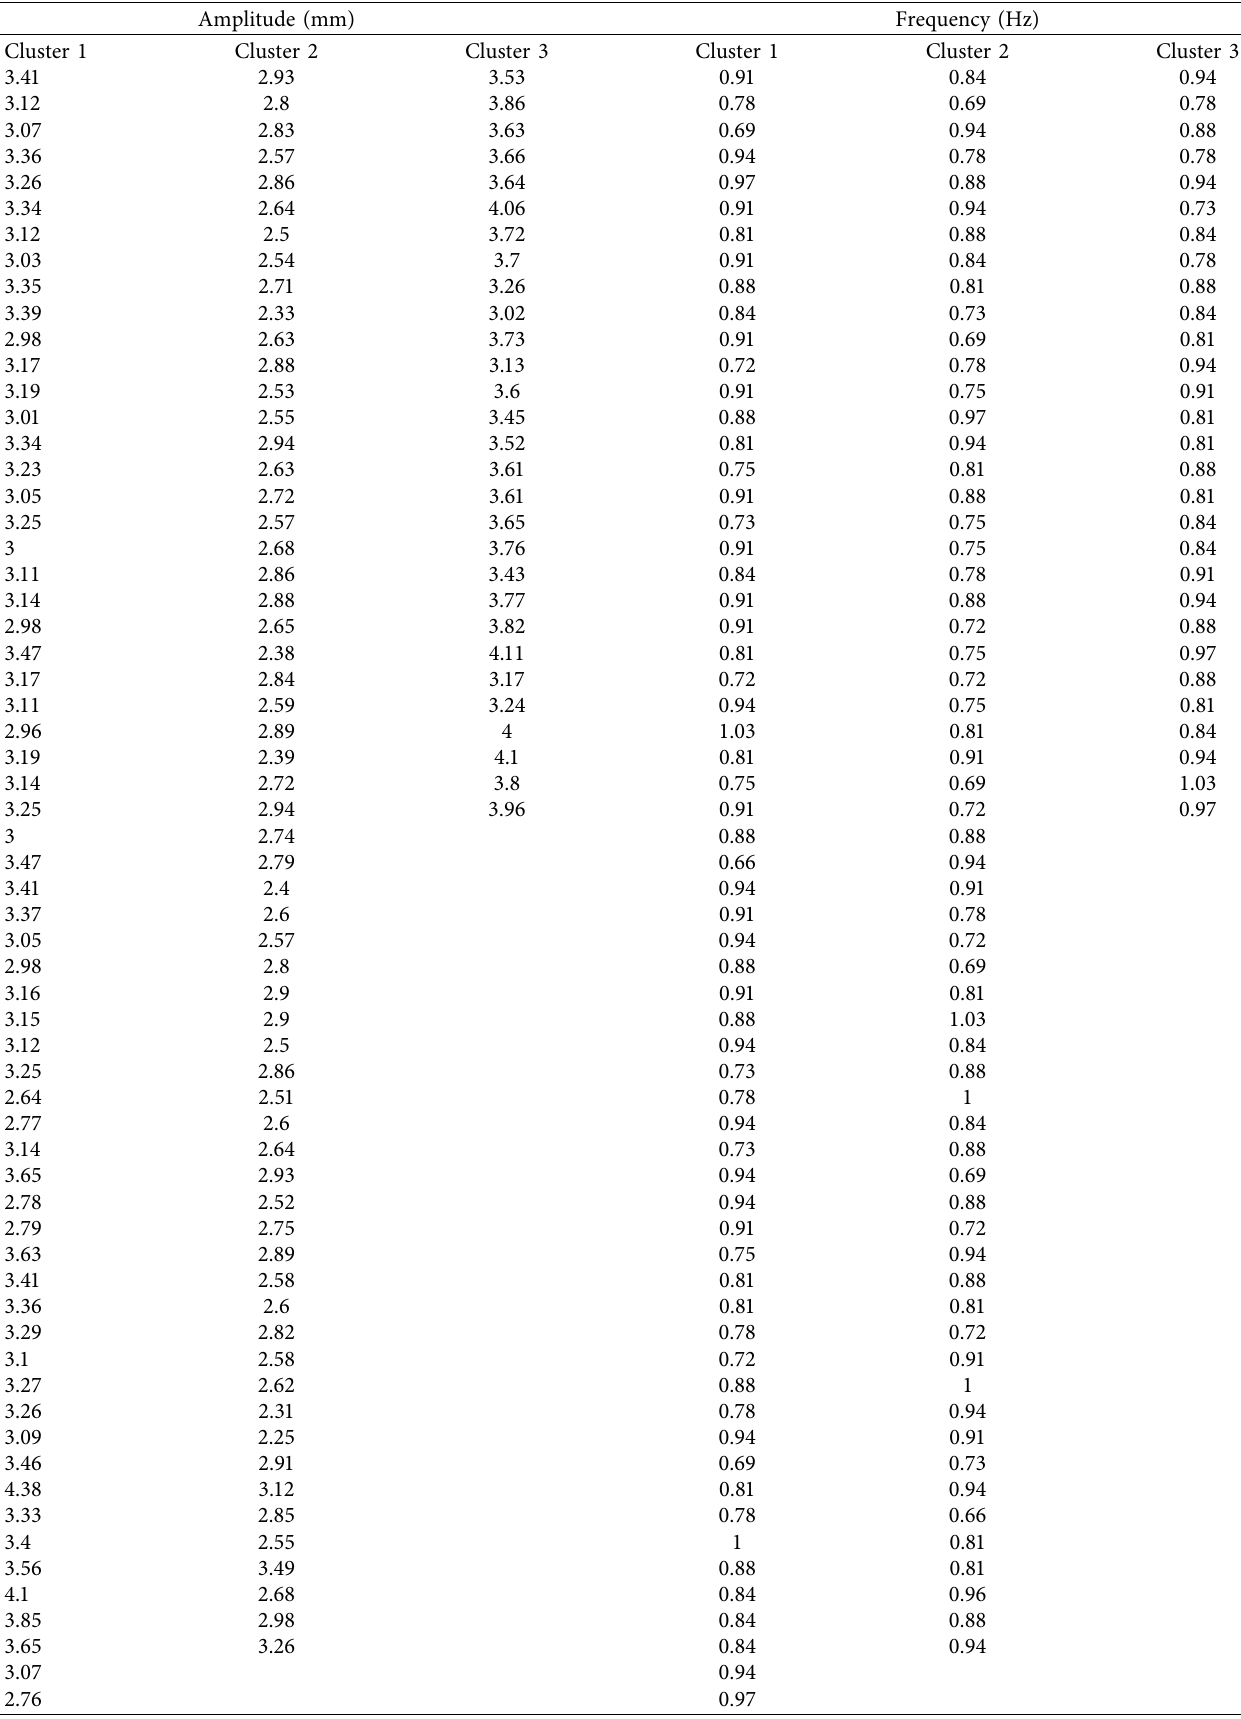
Table 5: Fuzzy C-mean clustering analysis of variance of three clusters for frequency and